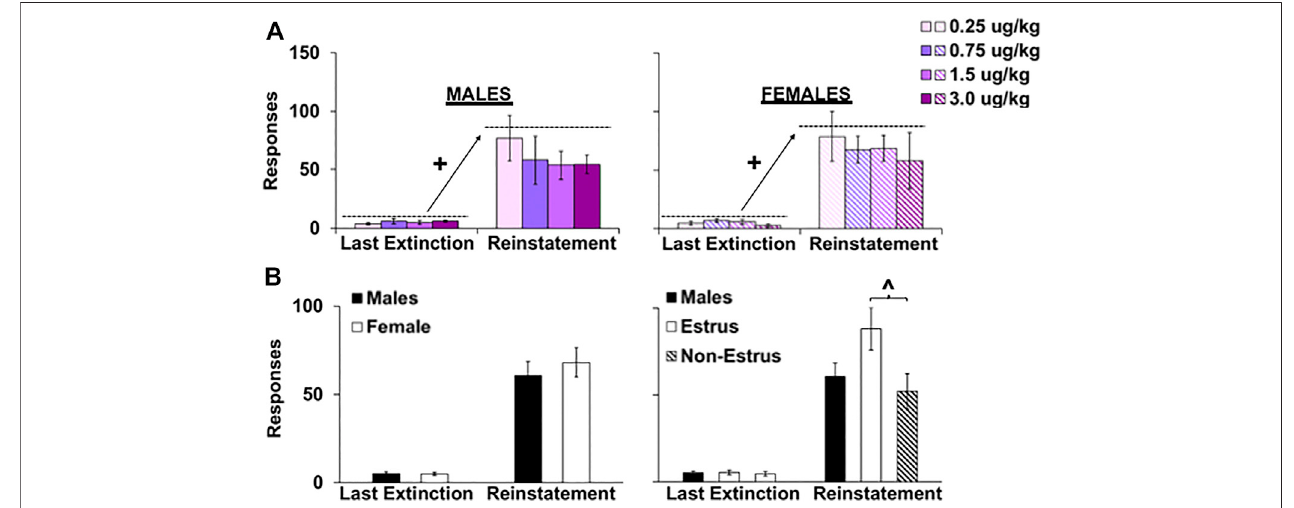
FIGURE 5 | Effect of sex, estrous cycle phase, and dose on responding during reinstatement testing in female and male rats. Mean (±SEM) number of responses made on the lever formerly associated with fentanyl during the last extinction session versus the reinstatement session for males (A; left) and females (right) within the 0.25 ( n = 8 males, n = 9 females), 0.75 ( n = 8 males, n = 9 females), 1.5 ( n = 8 males, n = 8 females), and 3.0 ( n = 8 males, n = 7 females) dose ( μ g/kg) conditions and across all doses (B) ( n = 29 males, n = 29 females). (+) Signi fi cantly higher responding in the reinstatement session compared with the last extinction session. ( ^ ) Signi fi cantly higher responding in estrus females compared with non-estrus females.